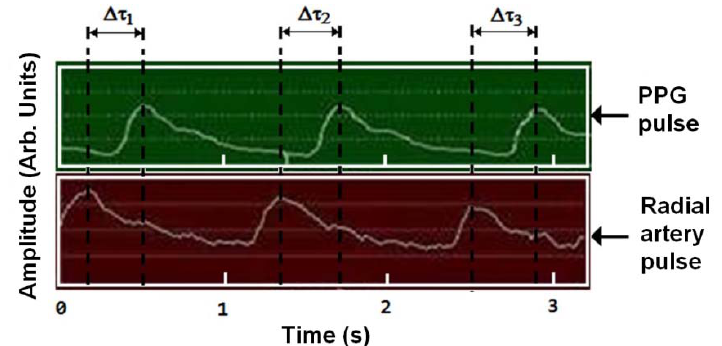
Figure 5. Radial artery pulse graph and PPG signals obtained from the simultaneous measurements by the clip-type pulsimeter and PPG meter mounted on the wrist and is the time interval measured from ith phase difference fingertip of the left hand. Here, Δτ i of the two pulse